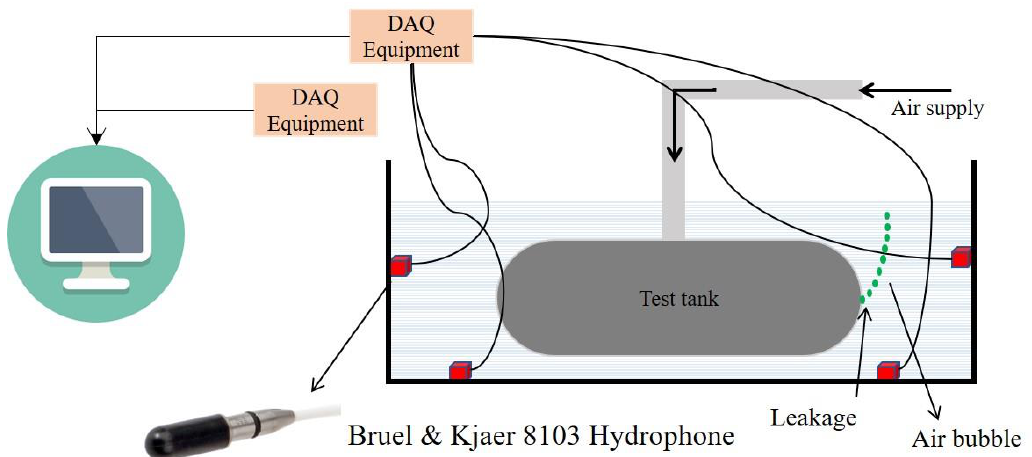
Figure 7. Schematic illustration of the experimental setup.